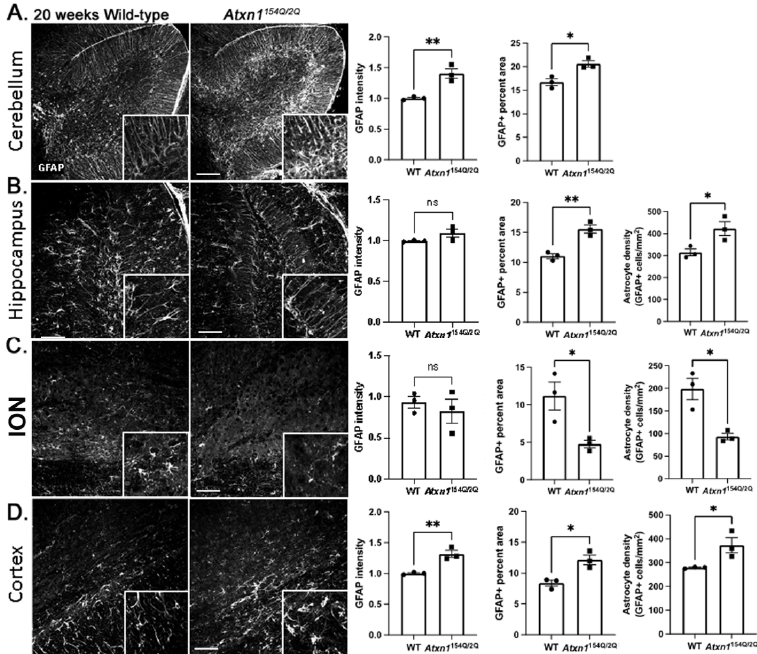
Figure 4. Spatial diversity of astrocytic morphology in Atxn1154Q/2Q mice at late disease stage. Brain sections from 20 weeks old Atxn1154Q/2Q and wild-type littermate controls were stained for GFAP. Confocal images of cerebellum (( A ), lobule X), hippocampus (( B ), dentate gyrus), brainstem (( C ), ION), and motor cortex (( D ), layer 6 and corpus callosum) were used to quantify GFAP intensity, density of astrocytes and GFAP area. Images were acquired at 20 × (636.16 µ m × 636.16 µ m). Scale bars show 100 µ m. Insets. in the lower right corners of each image show zoomed images (79.5 µ m × 79.5 µ m) for qualitative assessment of astrocyte morphology. Data are presented as mean ± SEM with average values for individual mice represented by a dot in bar graphs. N = 3–5 mice of each genotype (WT and Atxn1 154Q/2Q ). ns: not significant, * p < 0.05, ** p < 0.01, Students t -test. Using RNA sequencing, we compared the expression of astrocytic genes in these re- gions of Atxn1 154Q/2Q mice and their wild-type littermate controls. We found a significant decrease in the expression of astrocytic homeostatic genes Kcnj10 , Aqp4 , Gja1 , and Slc1a2 in all four regions in the late stage Atxn1 154Q/2Q mice (Figure 5). These results indicate tem- poral diversity of astrocyte phenotypes in SCA1 and suggest that brain-wide loss of astro- cyte core gene expression characterizes late stages of disease in Atxn1 154Q/2Q mice.